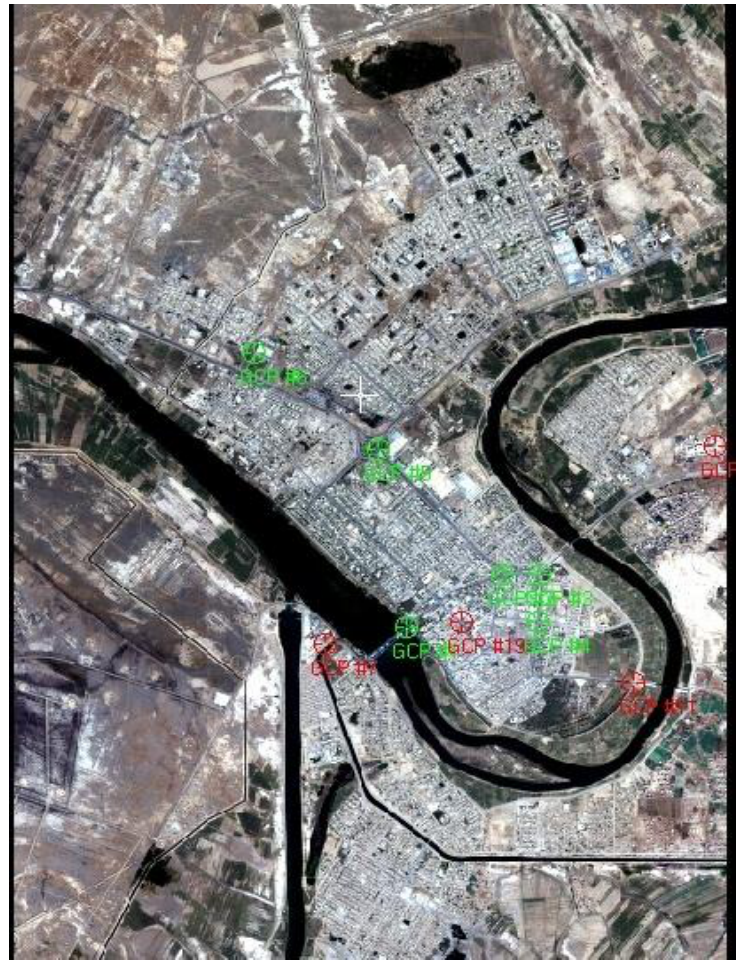
Fig.6: The location of 6GCPs with 4 check points. Table 3: The coordinate of 6GCPs with residual and total